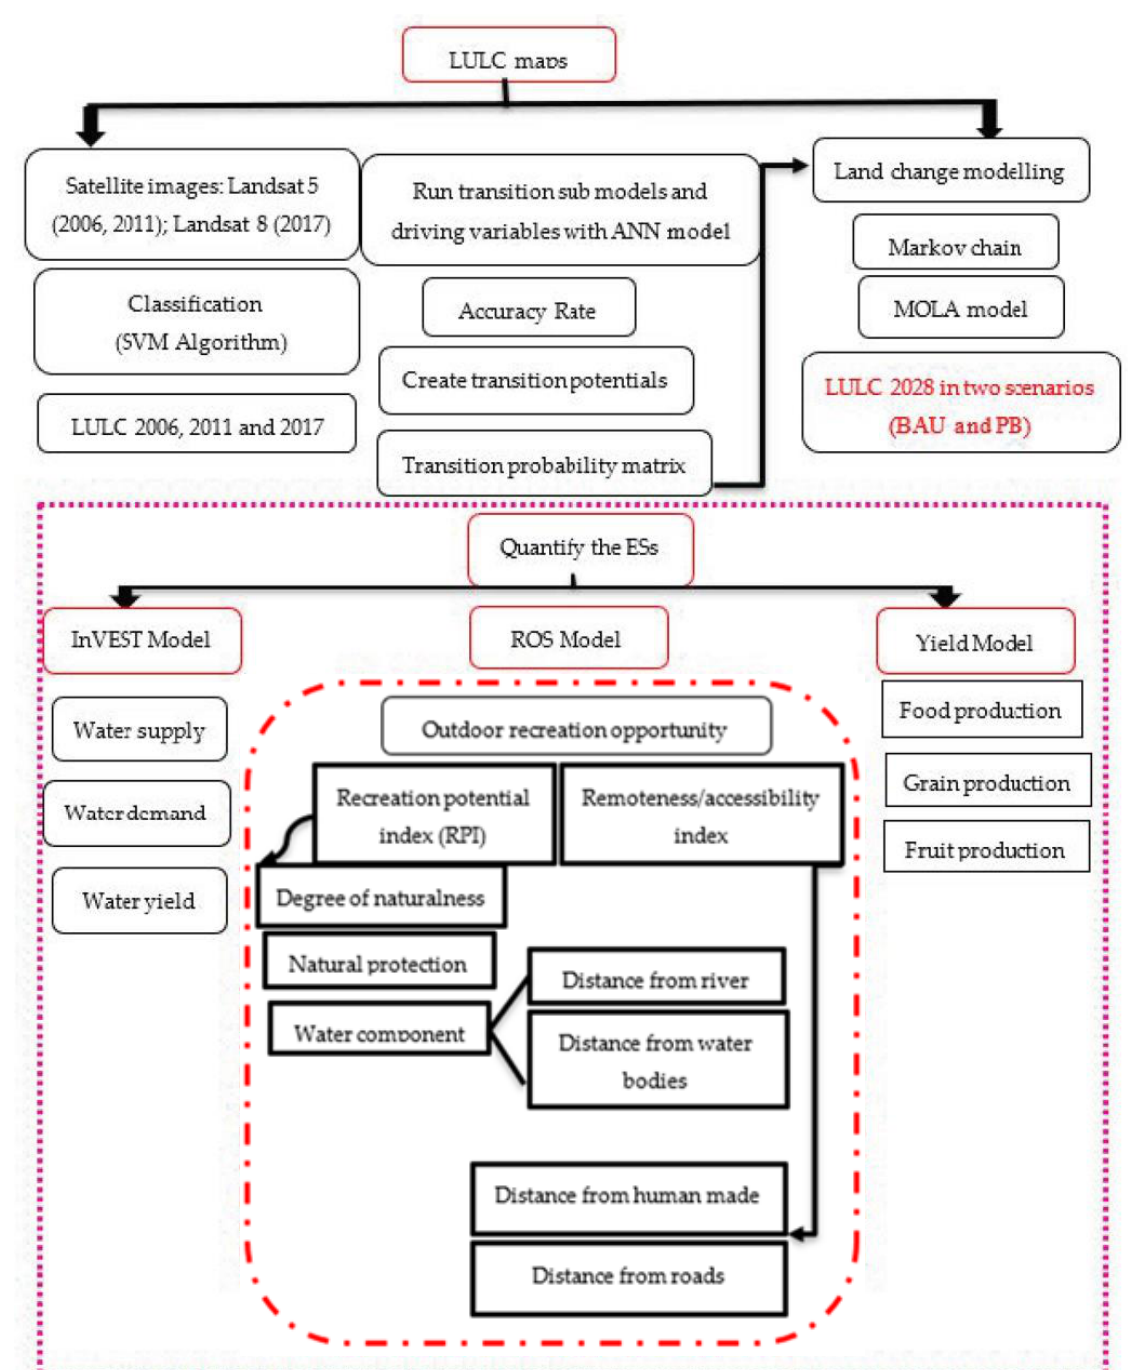
Figure 2. The general structure of the models used for urban expansion simulation and quantifying ESs.